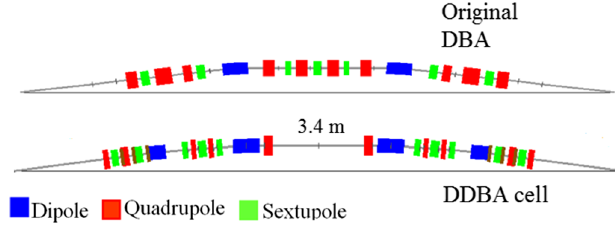
FIG. 1. DDBA layout compared to the existing DBA layout.